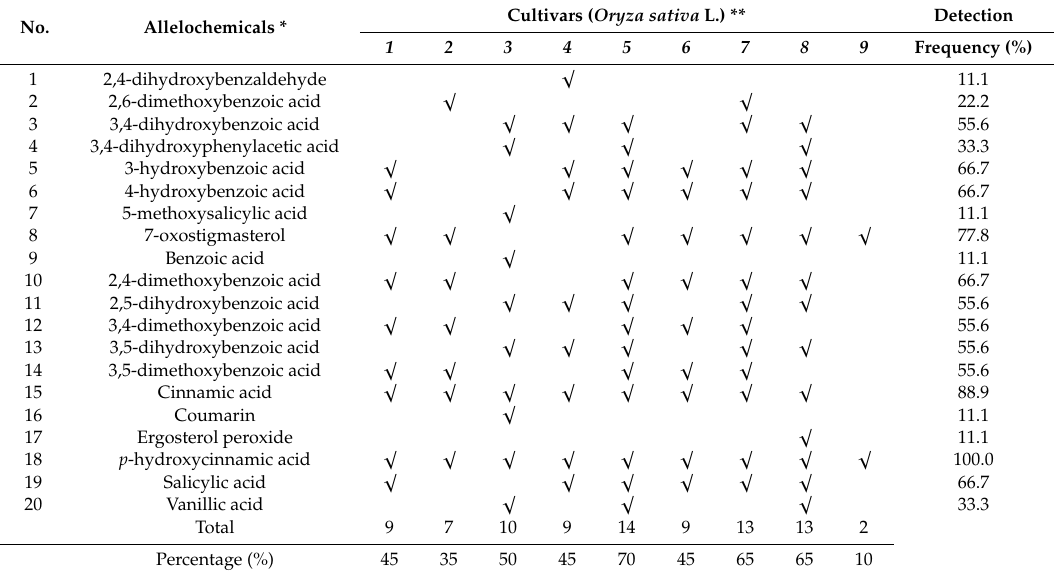
Table 3. A list of allelochemicals detected in 9 rice